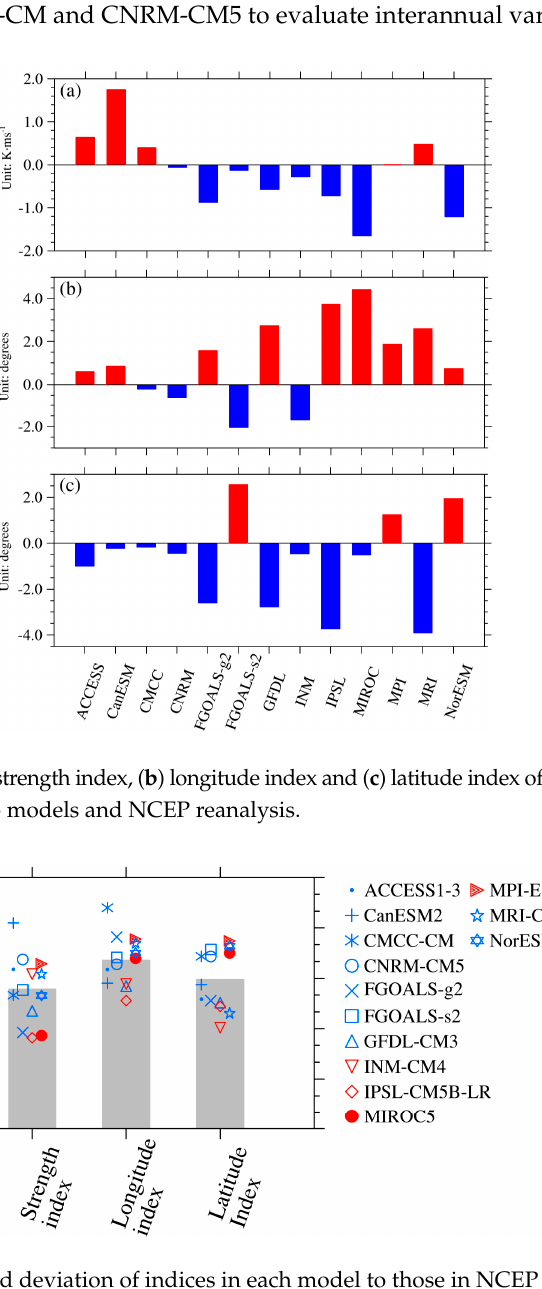
Figure 8. Ratio of standard deviation of indices in each model to those in NCEP reanalysis. Gray bar represents the MME of the corresponding index.